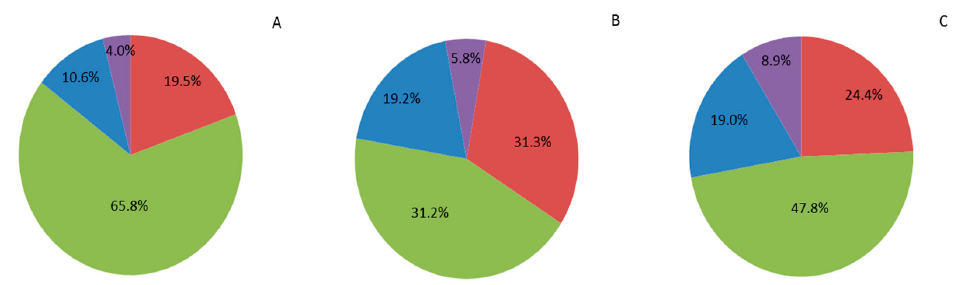
Figure 1. Olive fruit size distribution according to quality standards large size (160/180 fruit kg − 1 ), medium size (200/240 fruit kg − 1 ), small size (280/320 fruit kg − 1 ) and rejected (petite size). Adaptation from [39]. ( A ) one pollination; ( B ) two pollinations; ( C ) four pollinations. Trial 2017.